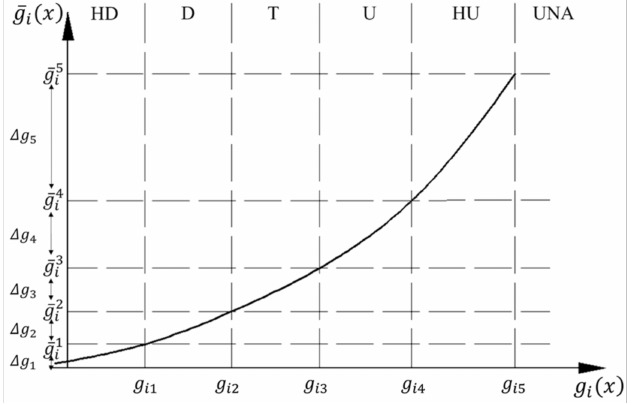
Figure 8. A class function of